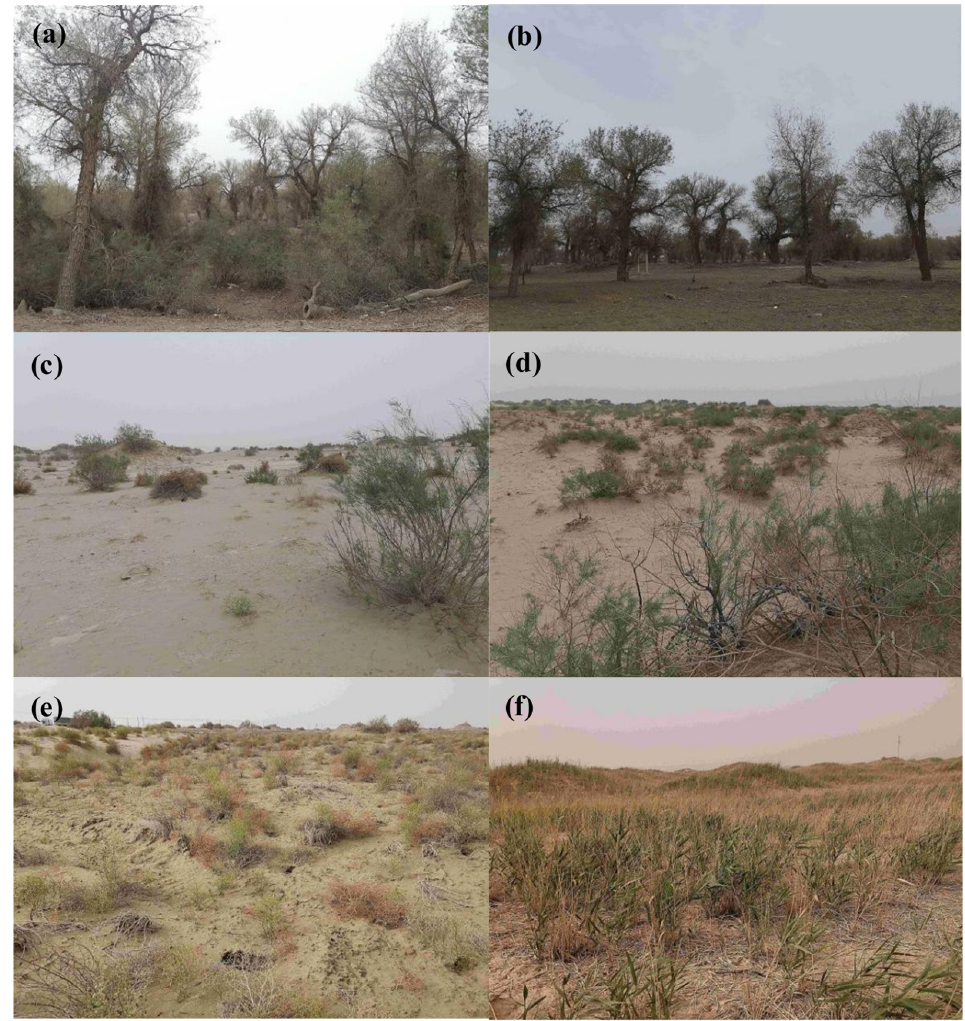
Figure 2. Photographs of the different plant communities in the desert riparian forest of the Tarim River Basin including ( a , b ) the Populus euphratica forest community; ( c , d ) the shrub community; and ( e , f ) the herb community.